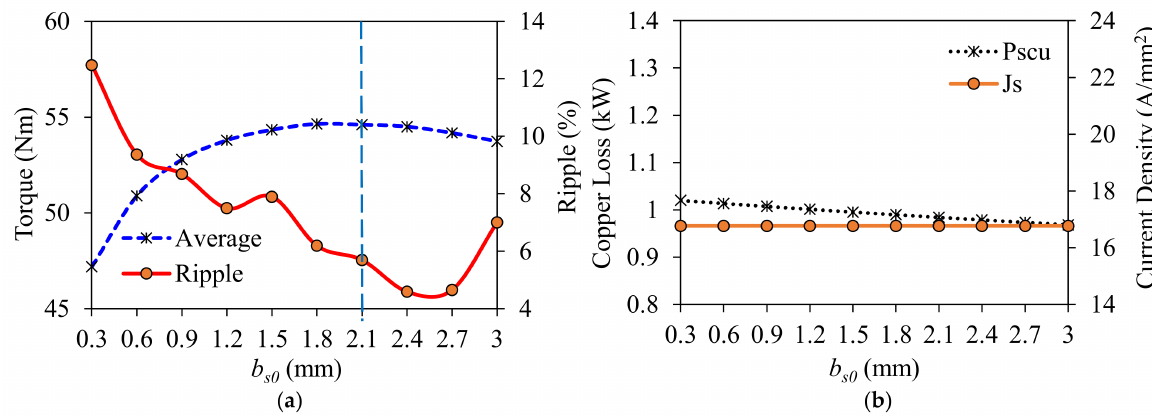
Figure 37. Variations of some key performance characteristics with b s 0 : ( a ) torque and torque ripple and ( b ) stator copper loss and current